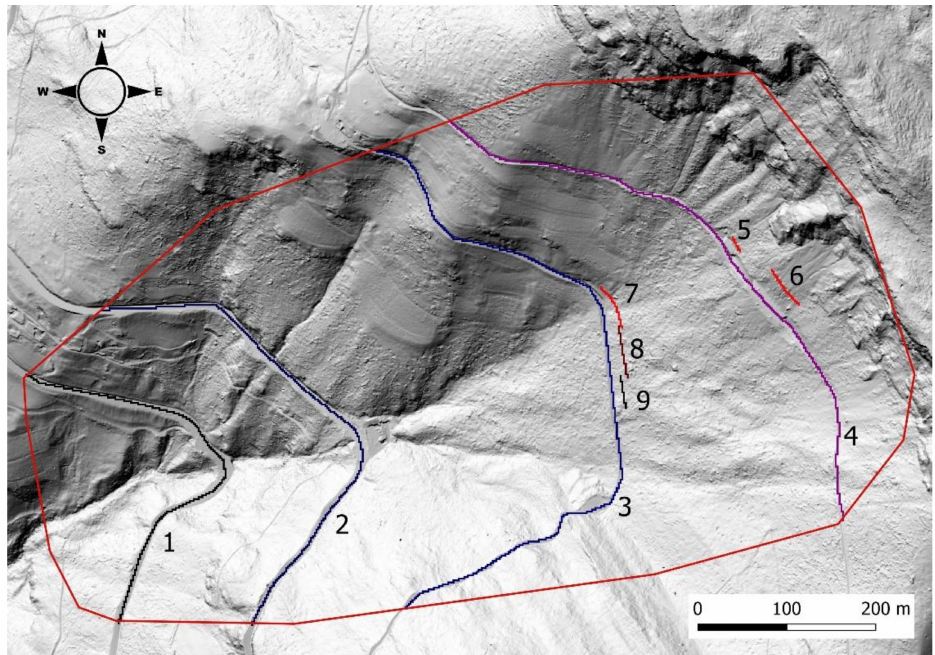
Figure 3. Position of the checkpoints used for computation of the indices. We identified the main roads, and the real nets present in the study area as checkpoints. The red line contours the study site, while the numbers indicate the ID of each checkpoint. High-resolution DTM from aerial surveys (acquired in 2019 by Veneto